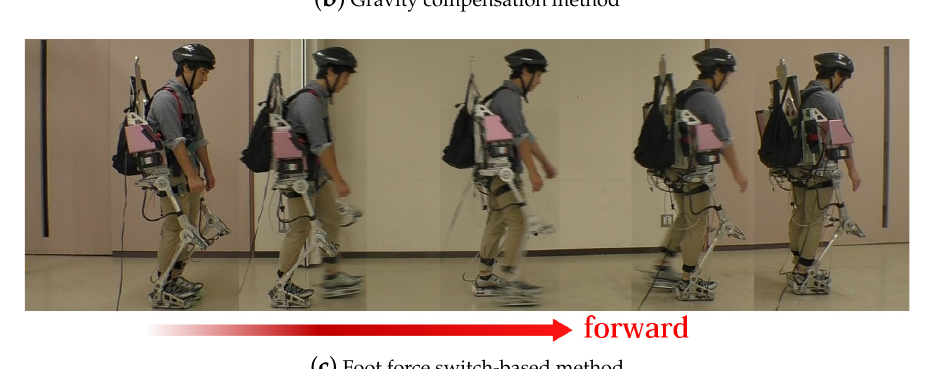
Figure 8. Image sequences of walking forward based on each method: the sampling time of image capture was approximately 1.8